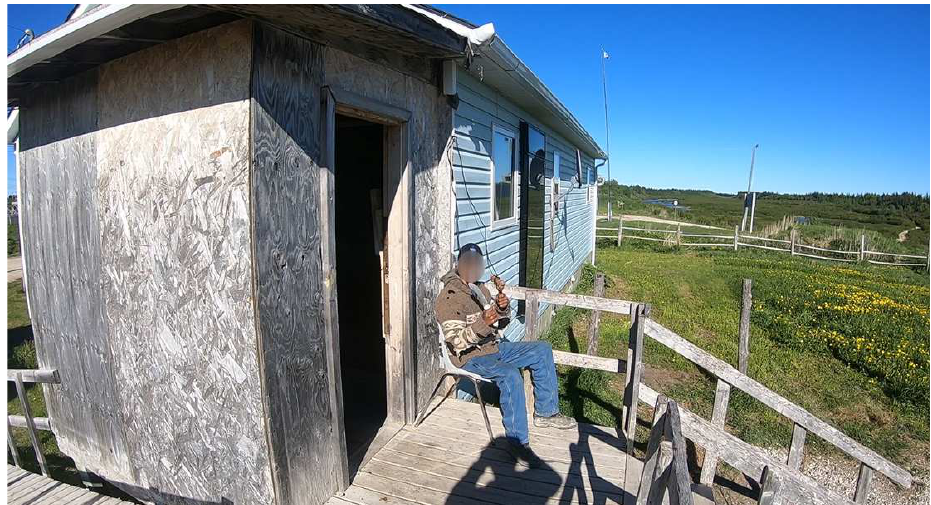
Figure 5. An on-the-land expert eating goose which was shared with him after the